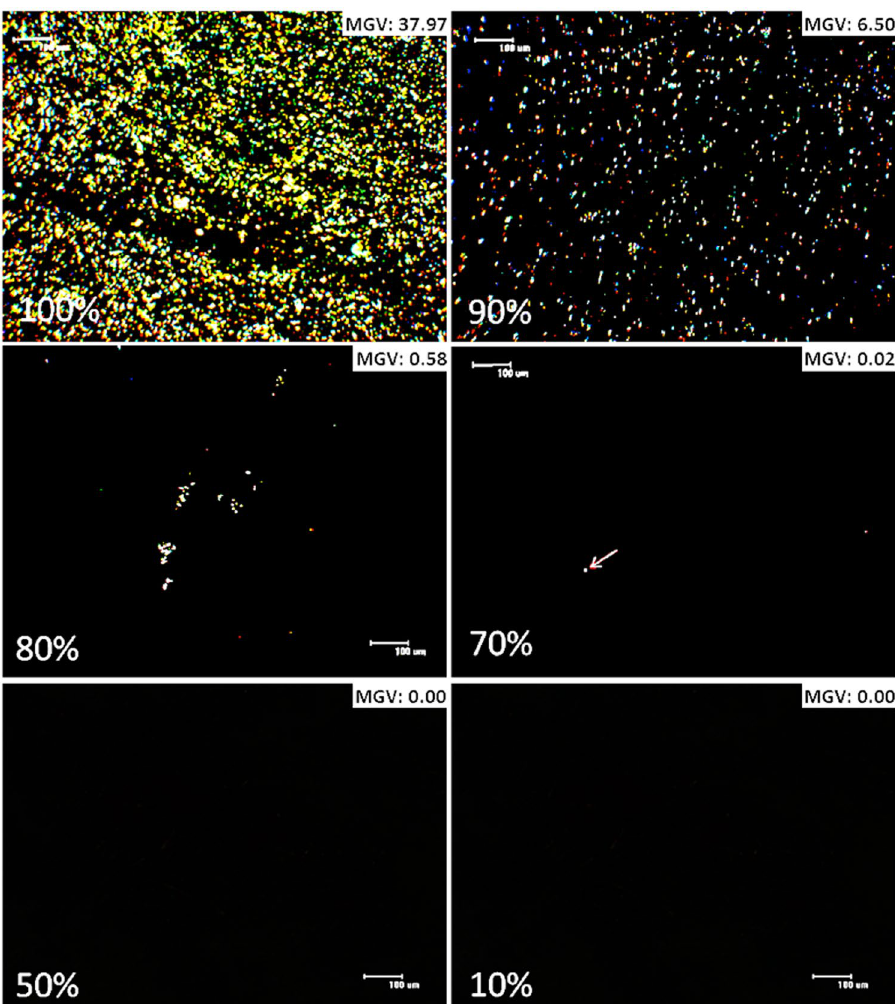
Figure 4. Polarized microscopy images of freeze-dried 100%, 90%, 80%, 70%, 50 and 10%w/w NIF in PVP. The crystal caused birefringence was observed to gradually decrease as the w/w% of NIF in PVP is reduced, while maintaining a constant 10 mg dose of NIF per capsule. The mean grey value (MGV) is listed on the top right corner of each image. 10 and 50% w/w NIF in PVP show no birefringence, thus MGV is at its lowest, while 90 and 100%w/w NIF in PVP show a relatively high amount of birefringence, this is shown in their shown in their